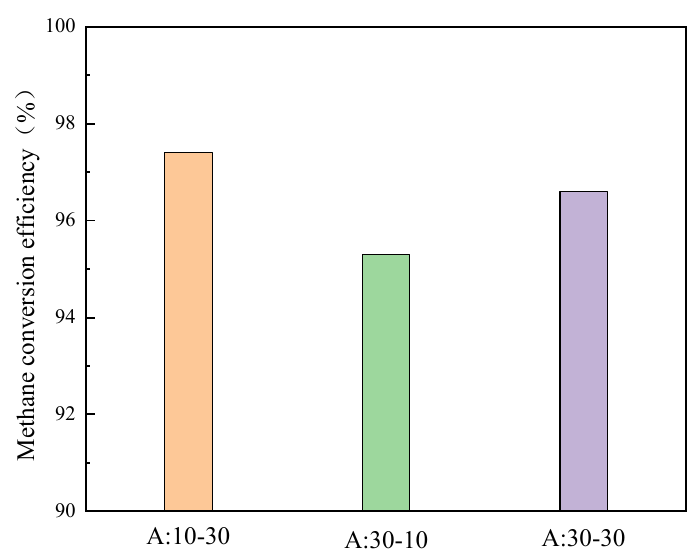
Figure 7. Methane conversion efficiency of different combustor.